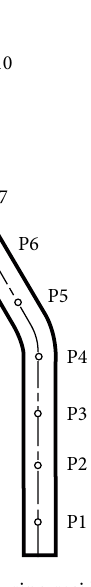
Figure 2: Locations for measuring residual wall thickness.